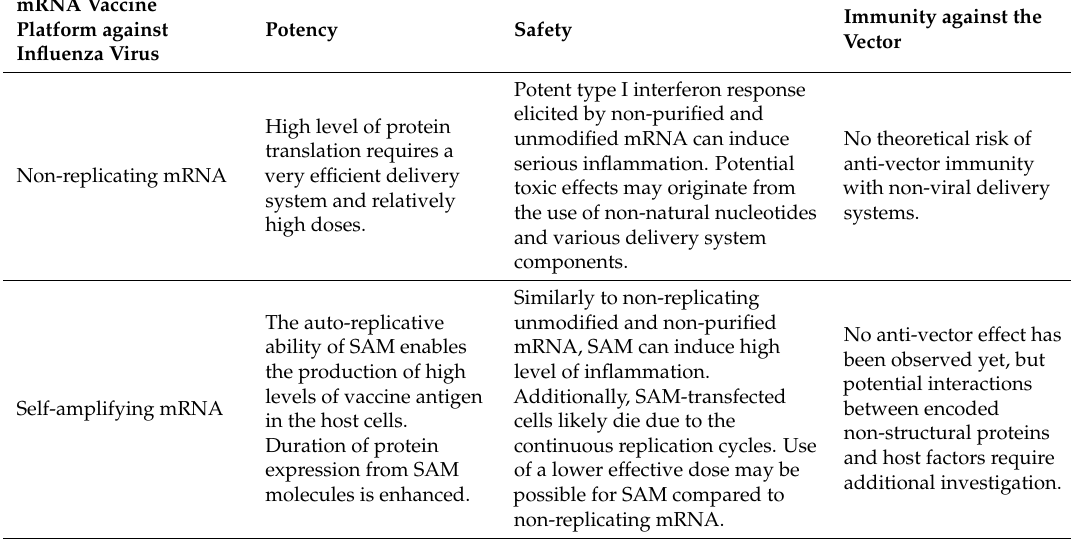
Table 3. Advantages and disadvantages of non-replicating mRNA and SAM